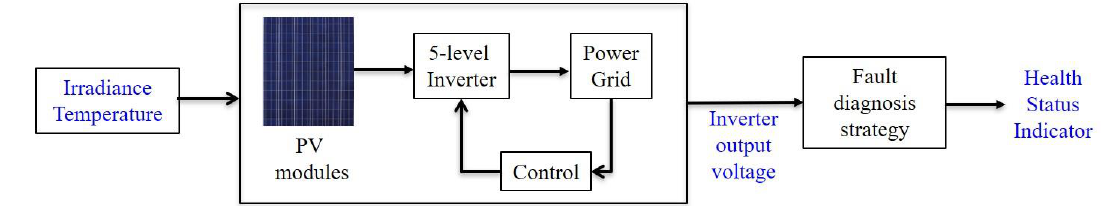
Figure 7. Grid-connected PV plant fault diagnosis block diagram.